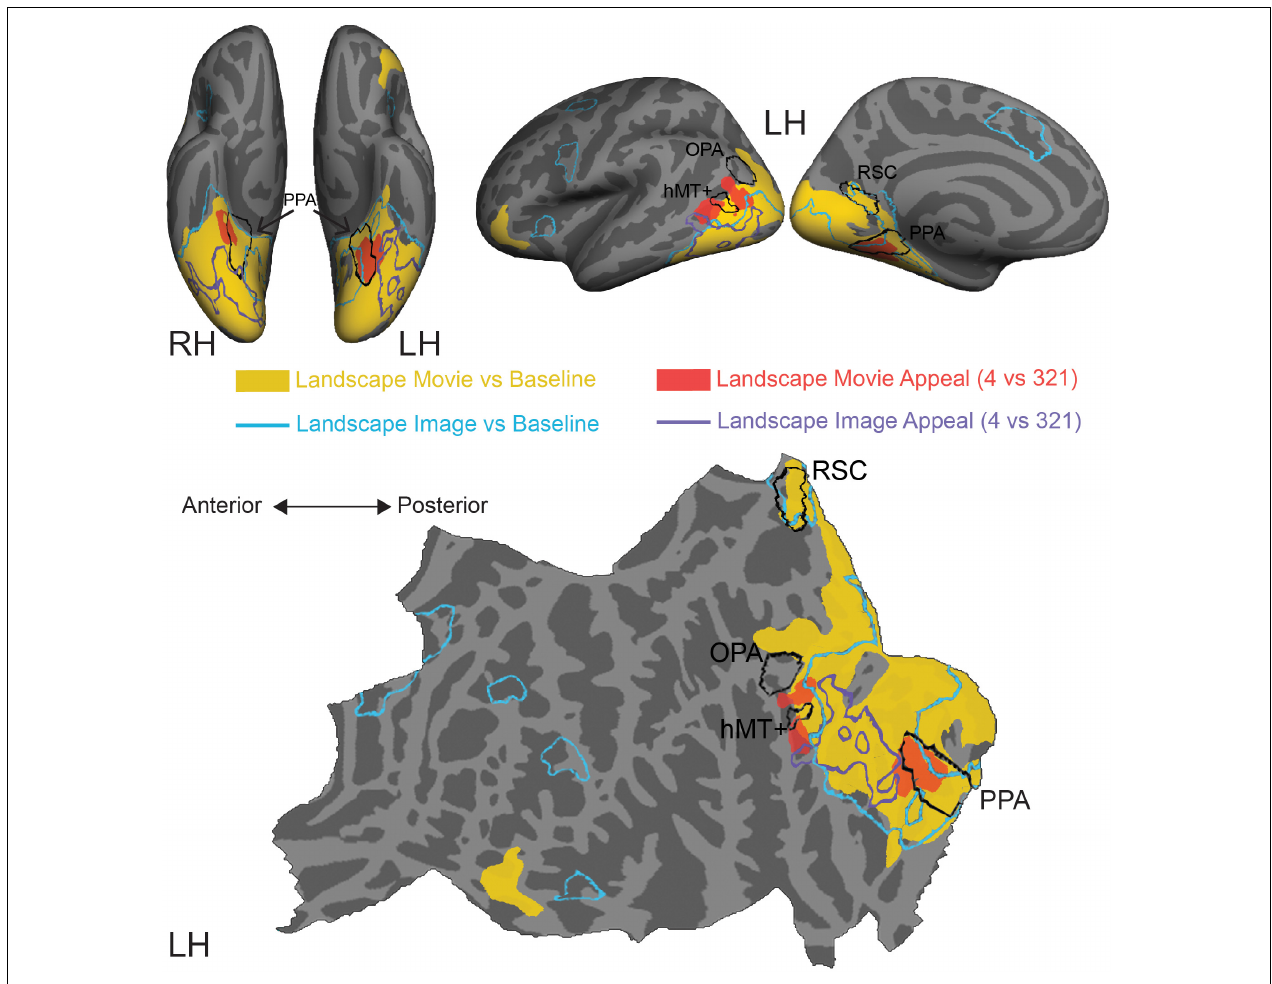
FIGURE 4 | Comparison of stimulus-induced and appeal-related activations for both movies and still images of natural landscapes. Significant clusters from stimulus vs. baseline and aesthetic appeal contrasts (4 vs. 321) from two experiments were rendered on Freesurfer’s fsaverage cortical surface. Solid warm colors illustrate movie vs. baseline contrast (yellow) and effect of high appeal movies (4 vs. 321, red). Outlined cold colors illustrate still images vs. baseline contrast (teal) and effect of high appeal images (4 vs. 321, purple) obtained with static natural landscape images from Vessel et al. (2019). Top: inflated surfaces showing a ventral view of right (RH) and left (LH) hemispheres, and lateral and medial views of the left hemisphere. Bottom: flattened left hemisphere. Movie N = 24, Image N = 16.